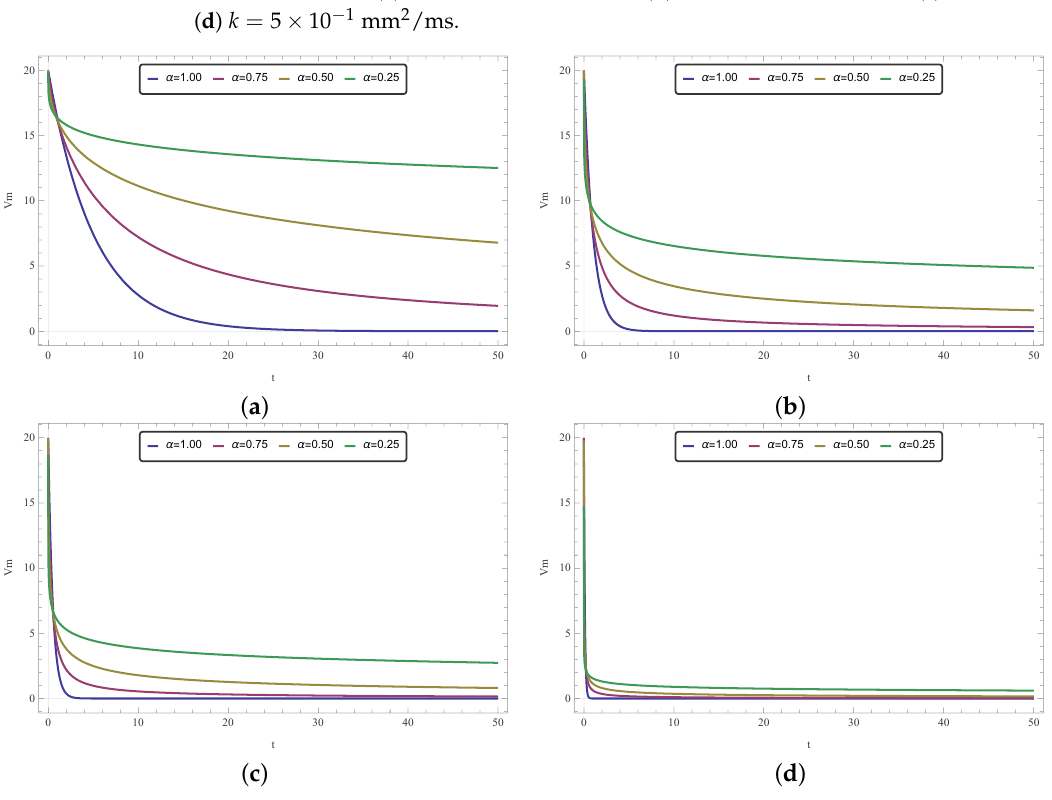
Figure 13. Time plots for Equation (27) with x = y = 0.5. Exploratory comparison between different values of α and k . ( a ) k = 1 × 10 − 2 mm 2 /ms, ( b ) k = 5 × 10 − 2 mm 2 /ms, ( c ) k = 1 × 10 − 1 mm 2 /ms, ( d ) k = 5 × 10 − 1 mm 2